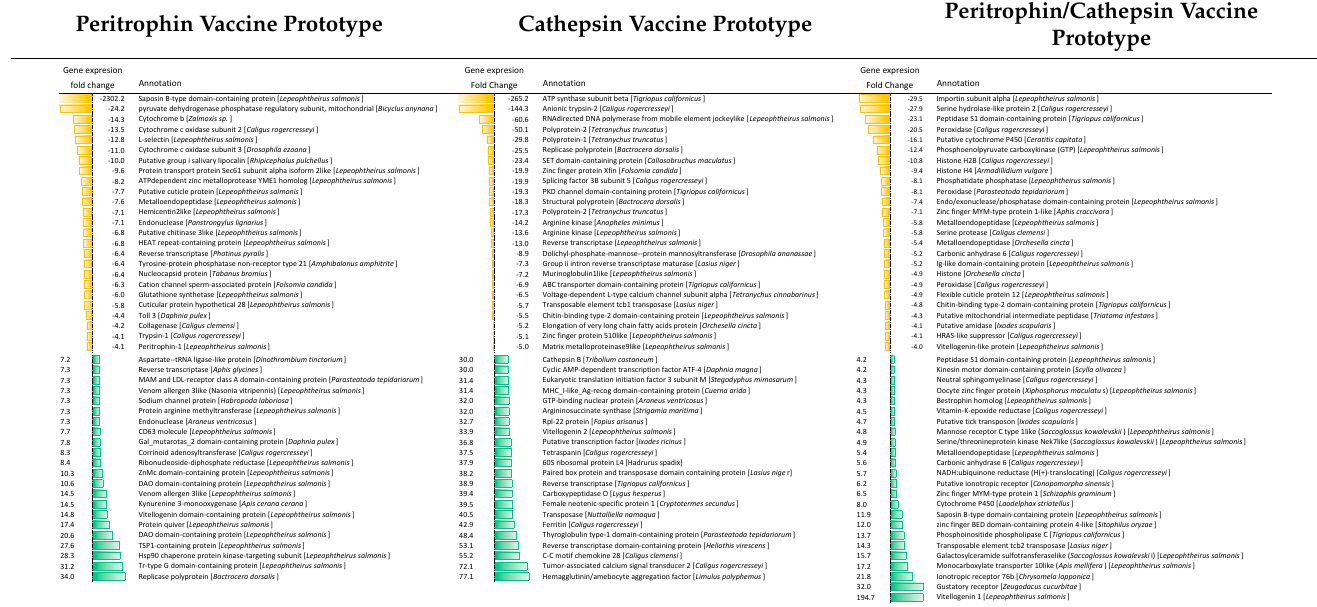
Table 1. Annotation of differentially expressed contigs in C. rogercresseyi exposed to vaccinated fish. Yellow bars represent downregulated contigs. Green bars represent upregulated